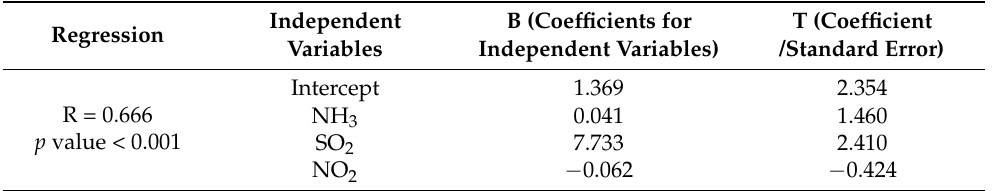
Table 3. Multivariate linear regressions between ambient PM2.5 loading rate (dependent variable) and PM2.5 precursor gas emission rates from the barns.